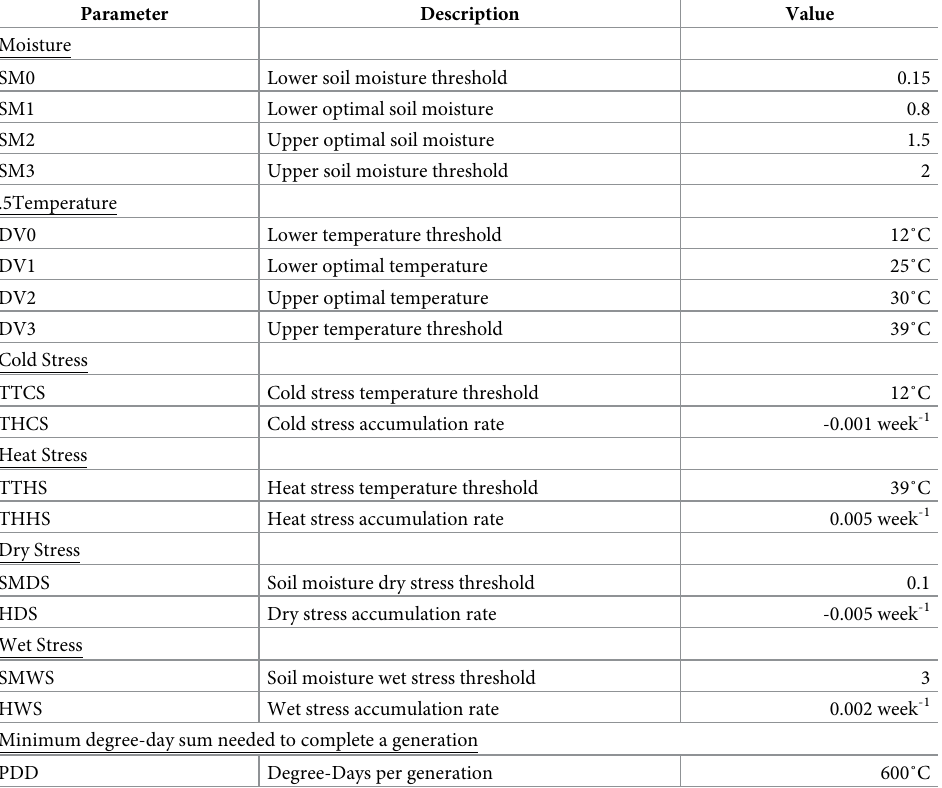
Table 2. CLIMEX parameter values used for modelling fall armyworm